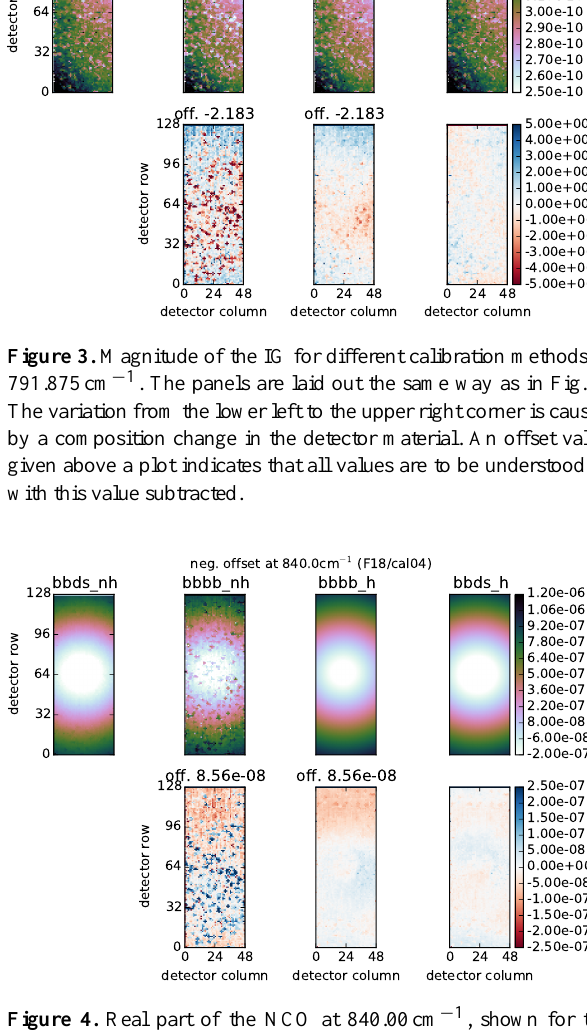
Figure 4. Real part of the NCO at 840.00cm − 1 , shown for the same calibration methods as in Fig. 2. Compared with the values at 791.875cm − 1 , this spectral sample cannot be as accurately repro- duced using the pseudo-hyperbola fit. An offset value given above a plot indicates that all values are to be understood as with this value subtracted.